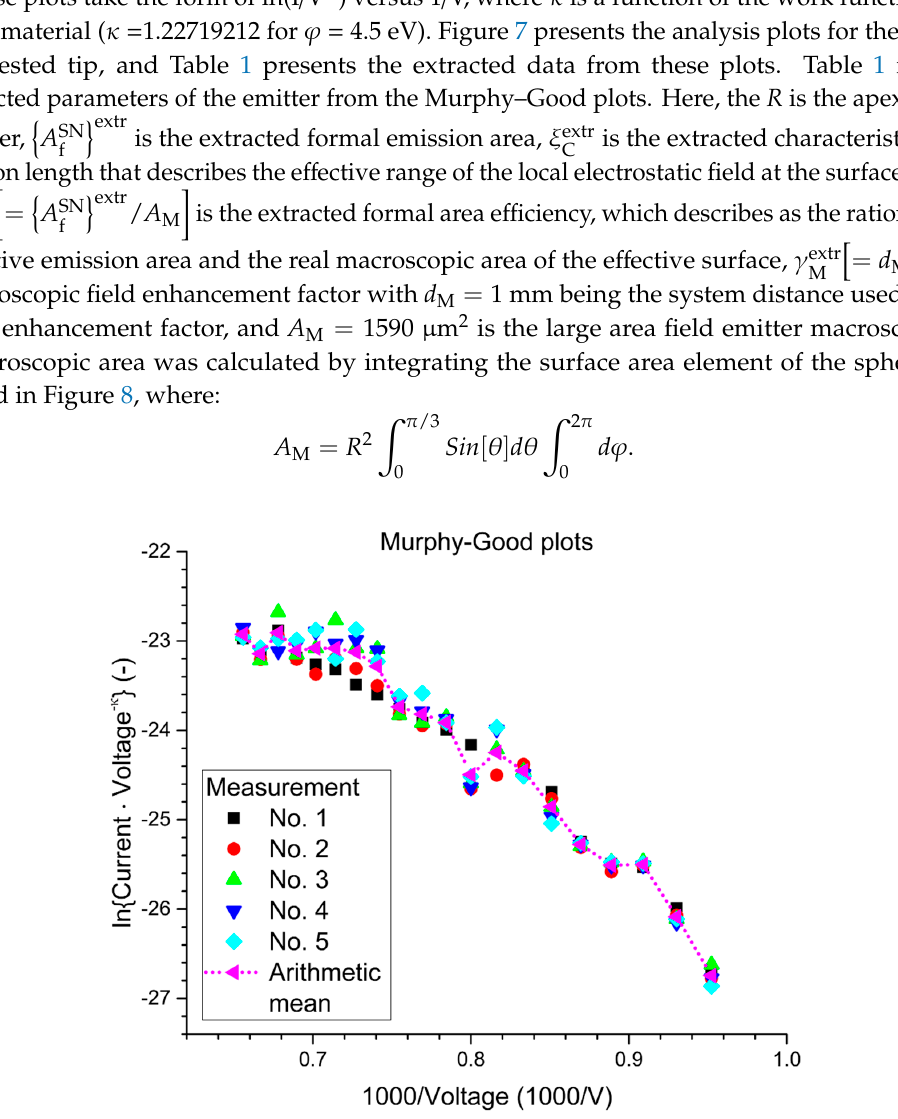
Figure 7. The analysis plots for the five cycles of the tested tip. Table 1. Extracted emitter’s parameters were obtained from the Murphy–Good